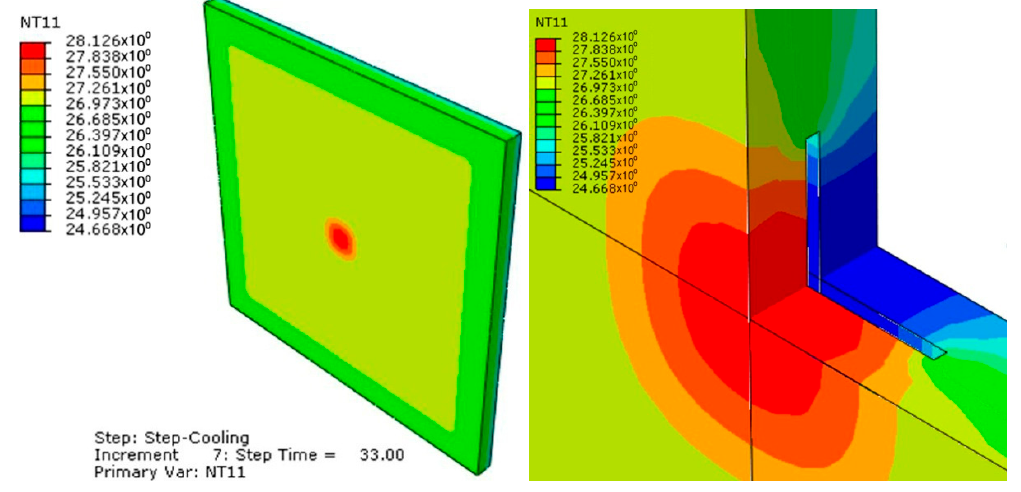
Figure 3. Model temperature distribution at 53 s .